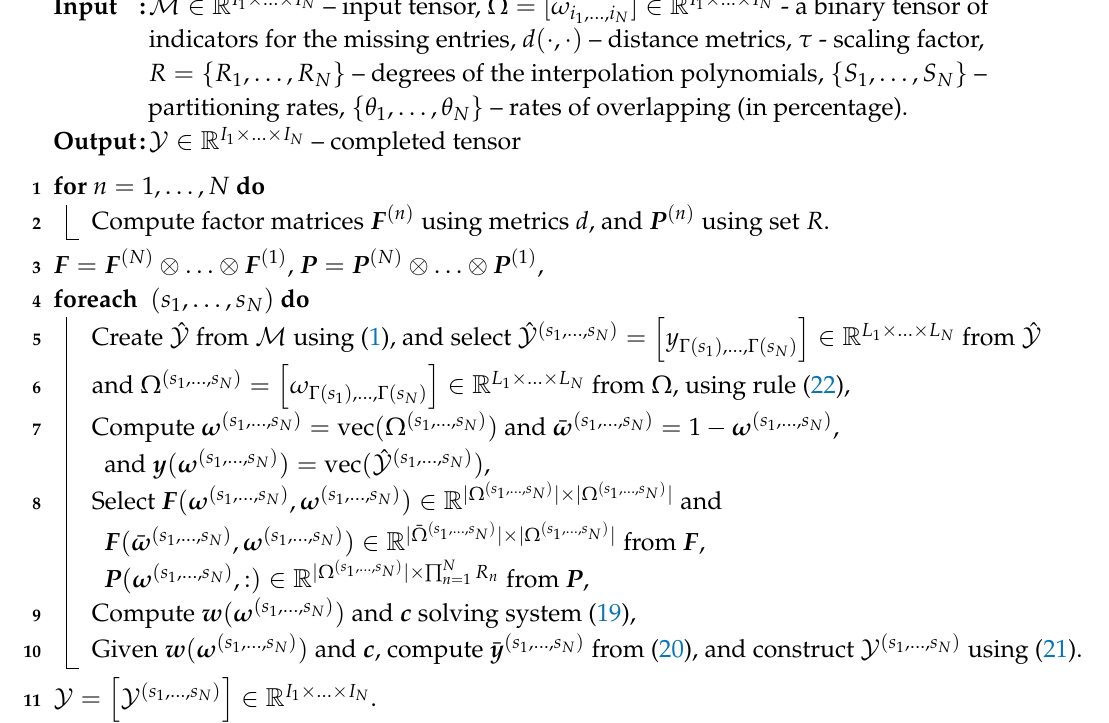
Algorithm 1: Tensorial Interpolation for Image Completion